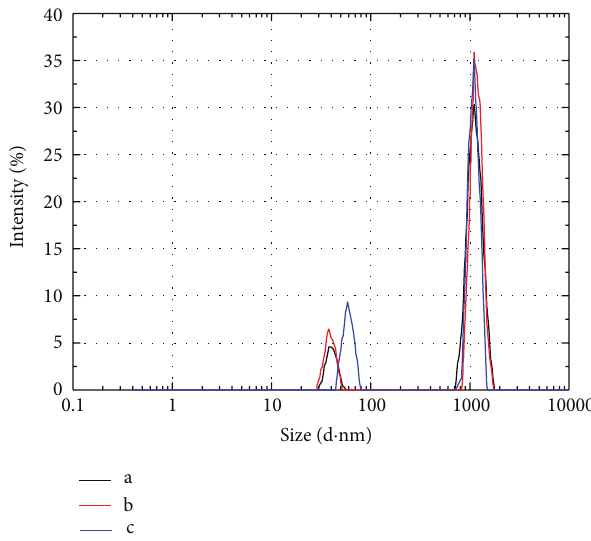
Figure 8: The effect of the salinity on the particle size of DPG. (a) In distilled water, (b) with 10,000mg/L NaCl added, and (c) with 10,000 mg/L NaCl and 2000 mg/L CaCl 2 added.